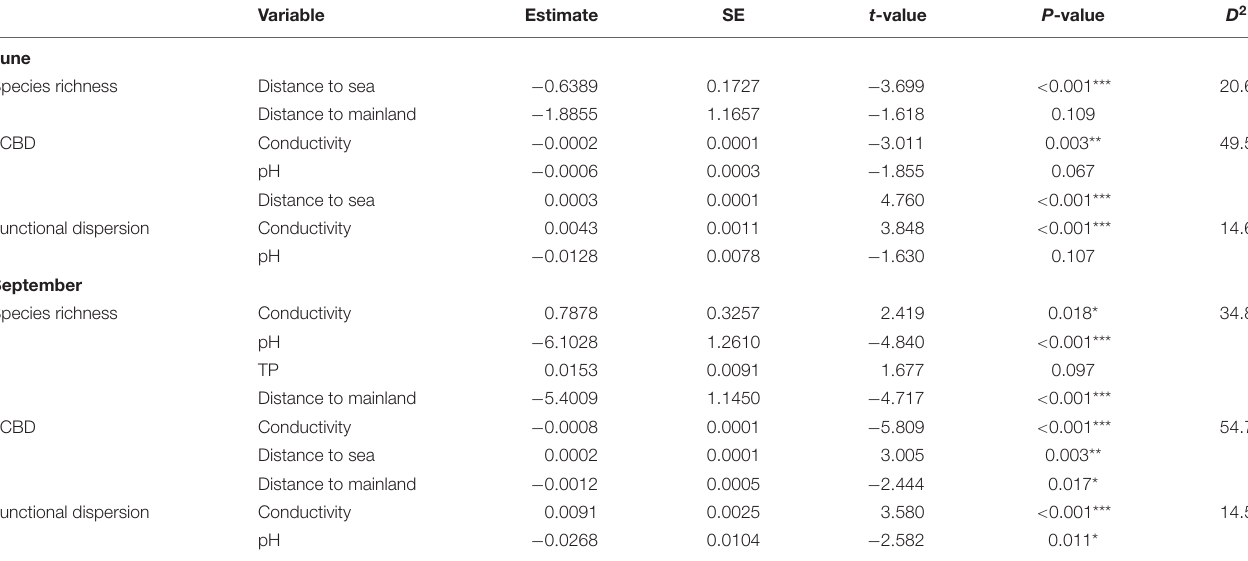
TABLE 1 | Results of the generalized linear models to explain the variation in species richness, local contributions to beta diversity (LCBD), and functional dispersion of rock pool diatom communities ( n = 91) in June and September.